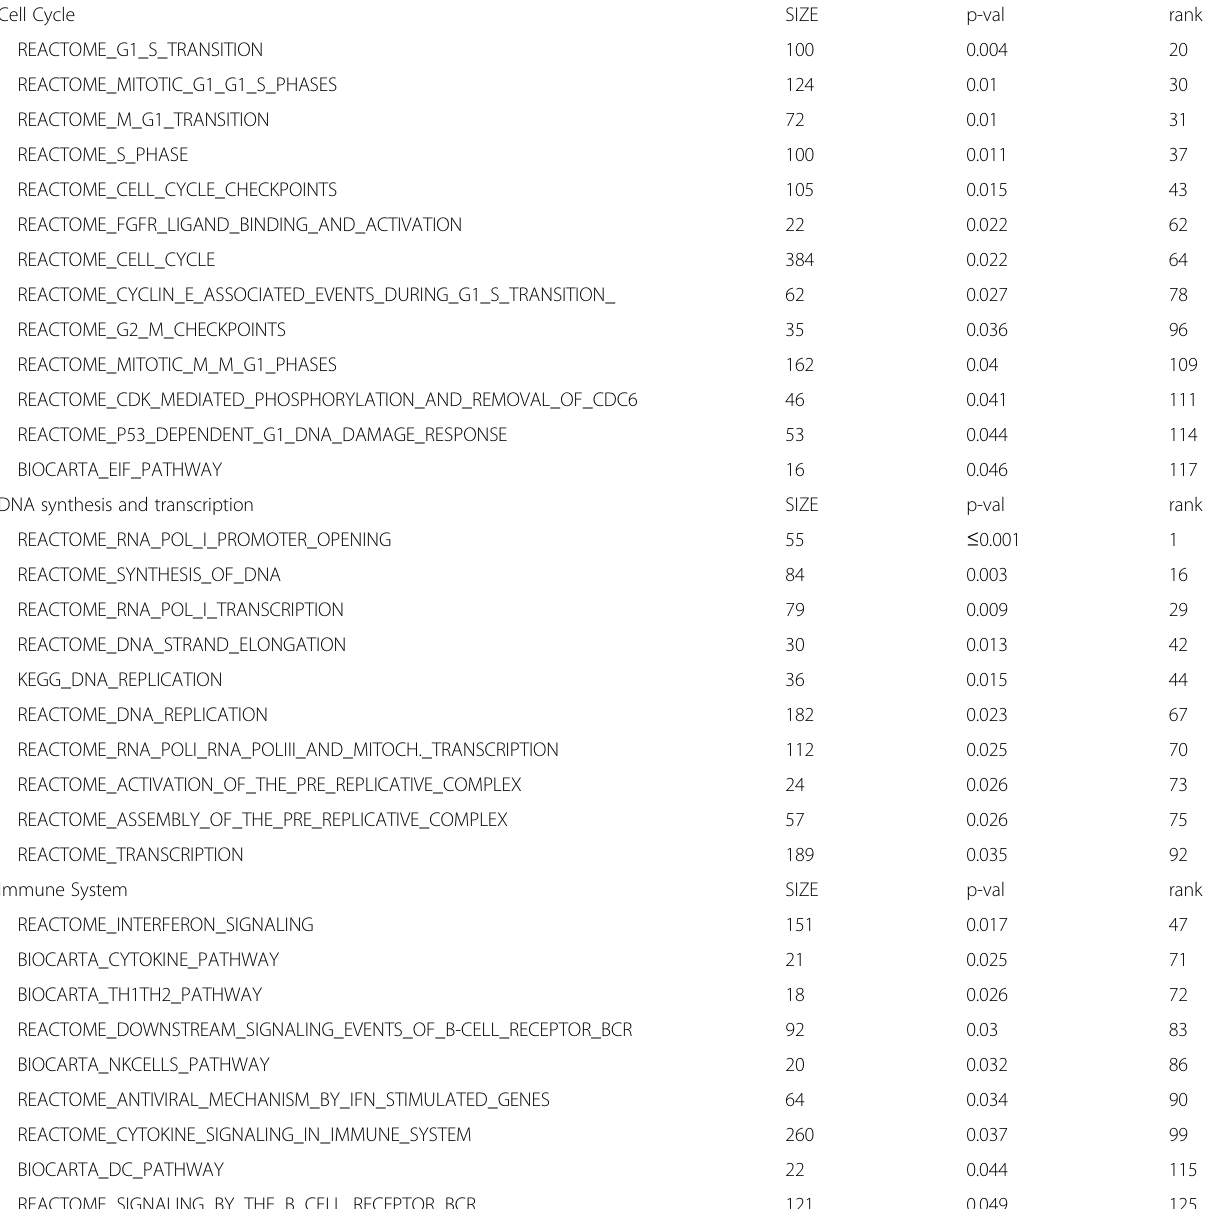
Table 3 Categories of top enriched pathways in transcriptomic datasets according to Gene Set Enrichment Analysis (GSEA) Cell Cycle SIZE